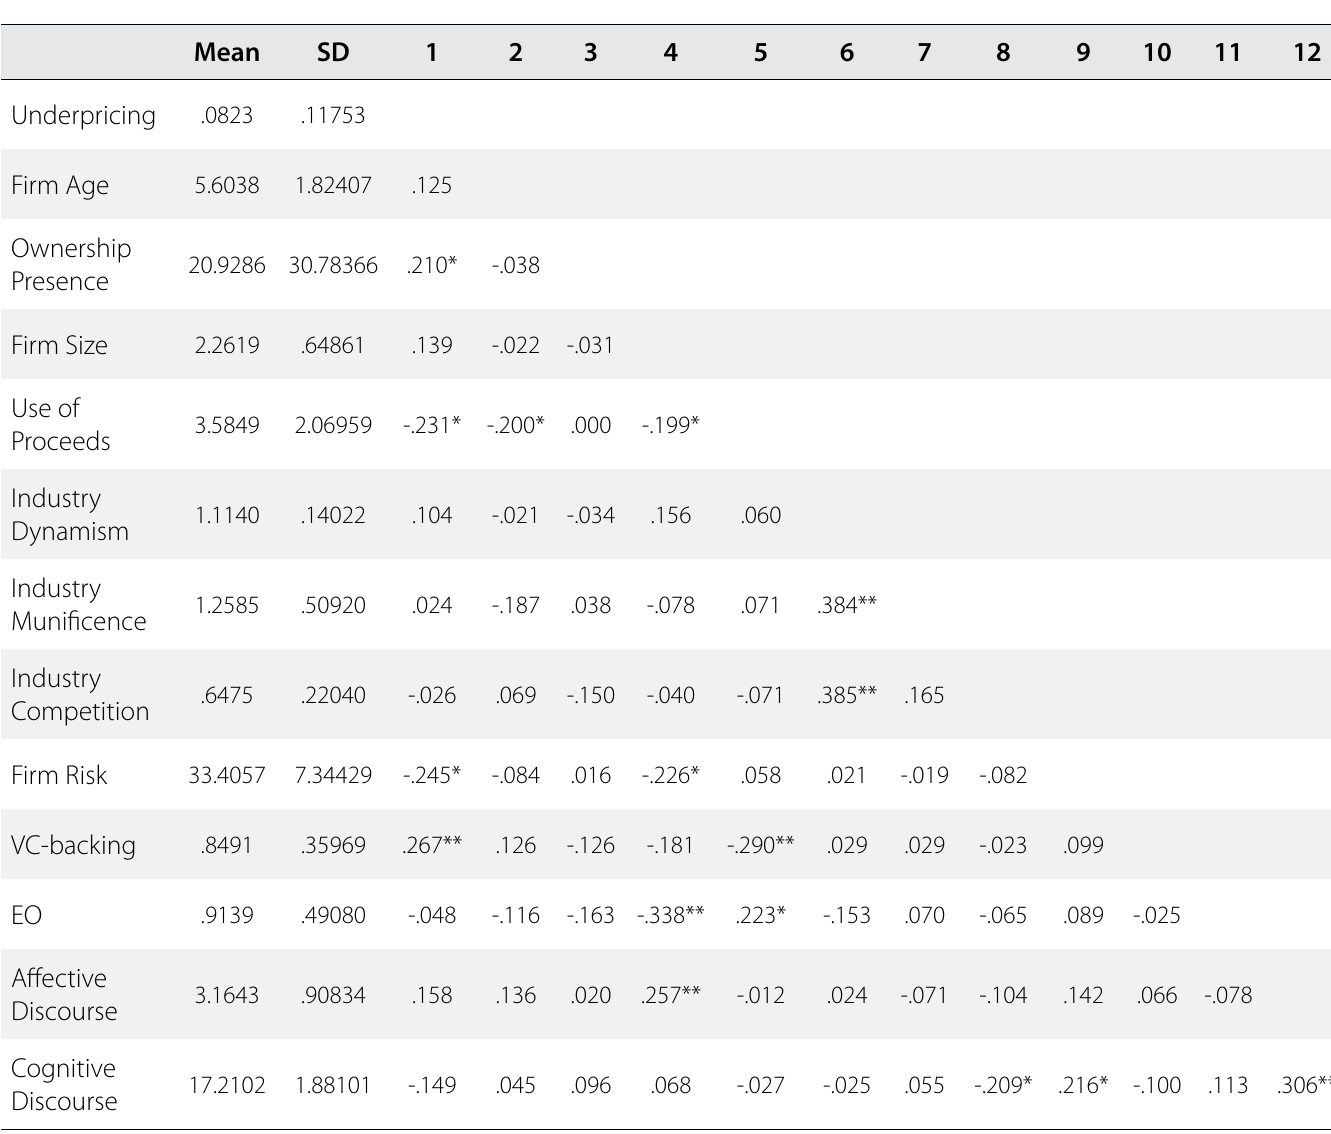
Table 1: Descriptive Statistics and